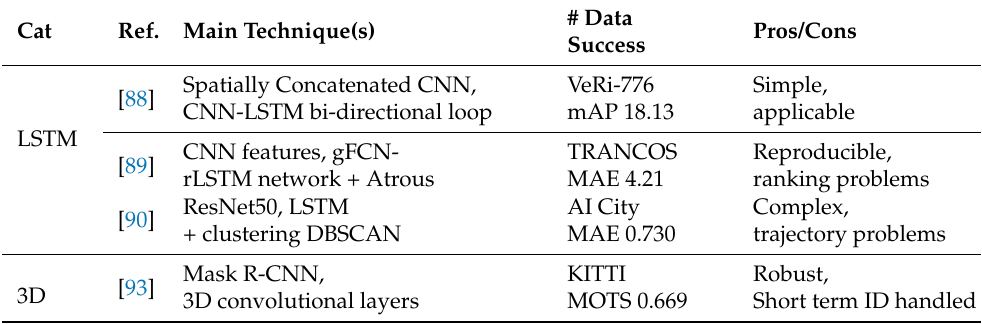
Table 8. Performance evaluation of the reviewed vehicle ReID using sequence learning